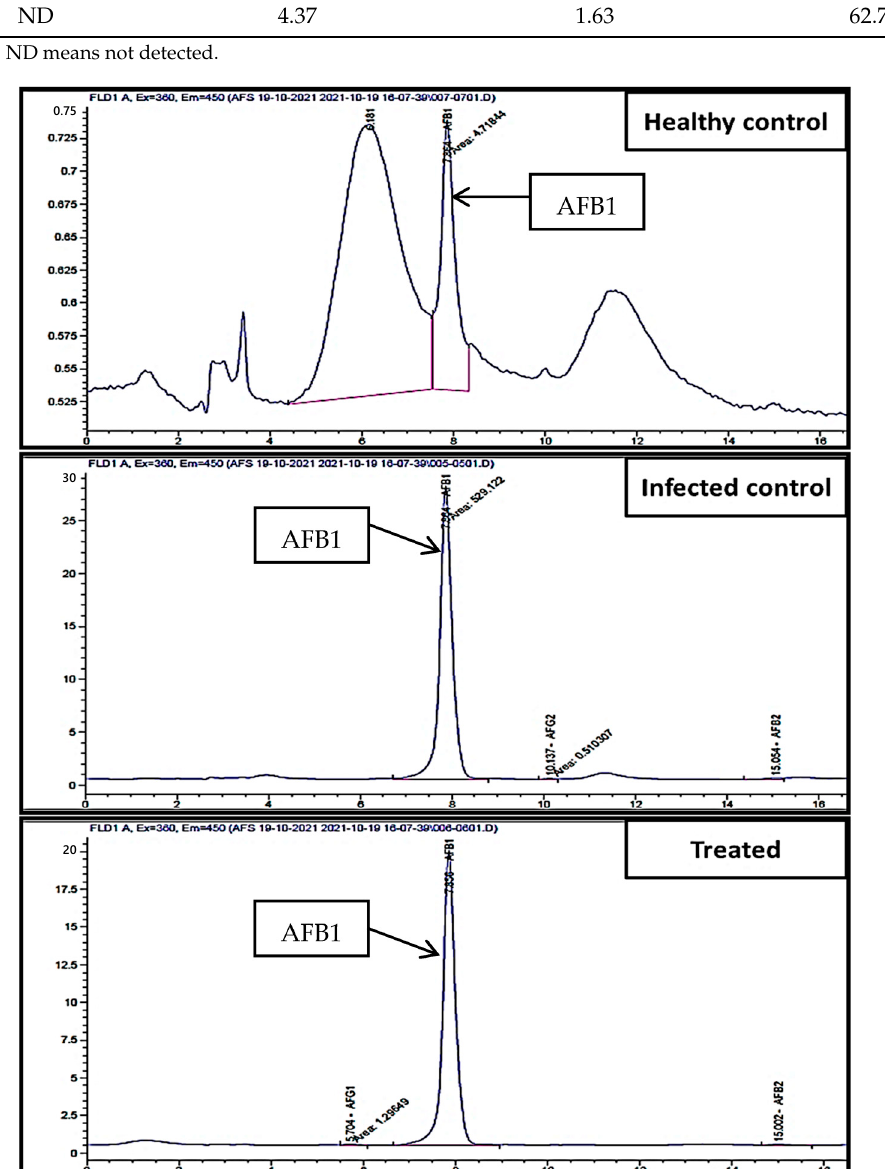
Figure 5. HPLC chromatogram of healthy and infected control and treated samples in in-vivo maize